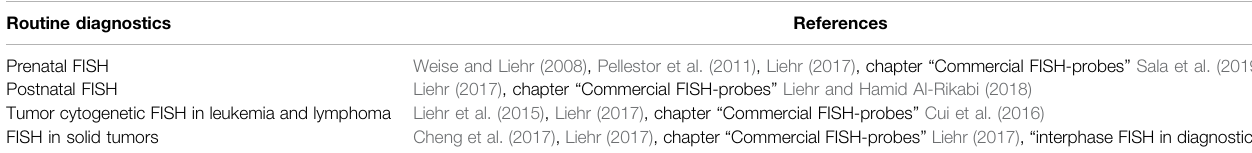
TABLE 1 | Literature and reviews on molecular cytogenetics in routine diagnostics for the major fi elds of application in human genetic diagnostics. Routine diagnostics